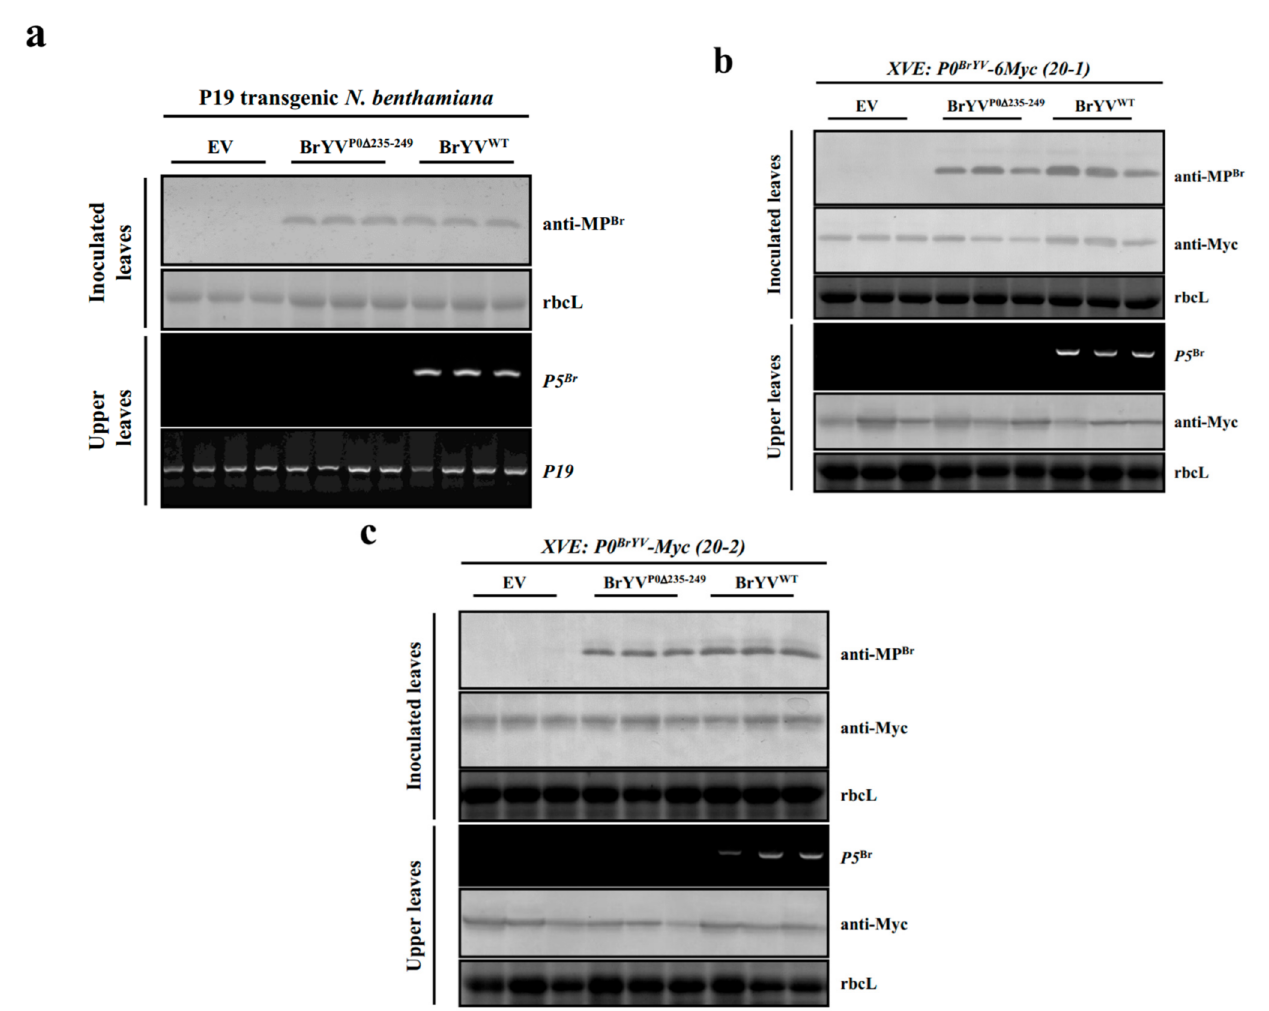
Figure 5. Stable P19 expression in transgenic plants or the heterologous stable expression of P0 Br protein did not rescue systemic infections by the BrYV C-terminal truncated mutant BrYV P0 ∆ 235–249 . ( a ) Protein determinations from virus-inoculated P19 transgenic N. benthamiana leaves at 2 dpi as assessed by Western blotting analysis using a BrYV-MP-specific antibody (anti-MP Br ). RNA determinations from the upper leaves of P19 transgenic N. benthamiana plants at 14 dpi as assessed by RT-PCR using P5 Br - and P19-specific primers. ( b , c ) Protein determinations from virus-inoculated XVE: P0 Br -6Myc transgenic N. benthamiana leaves at 2 dpi as assessed by Western blotting analysis using a Myc monoclonal antibody (anti-Myc) and a BrYV-MP-specific antibody (anti-MP Br ). RNA determinations from the upper leaves of XVE: P0 Br -6Myc transgenic N. benthamiana plants at 14 dpi as assessed by RT-PCR using P5 Br -specific primers. Western blotting analysis of P0 Br in XVE: P0 Br -6Myc transgenic N. benthamiana using a Myc monoclonal antibody (anti-Myc) at 14 dpi. Estradiol (100 µ M) was sprayed on leaves to induce expression of P0 Br -6Myc in transgenic N. benthamiana plants. 20-1 and 20-2 represent two transgenic